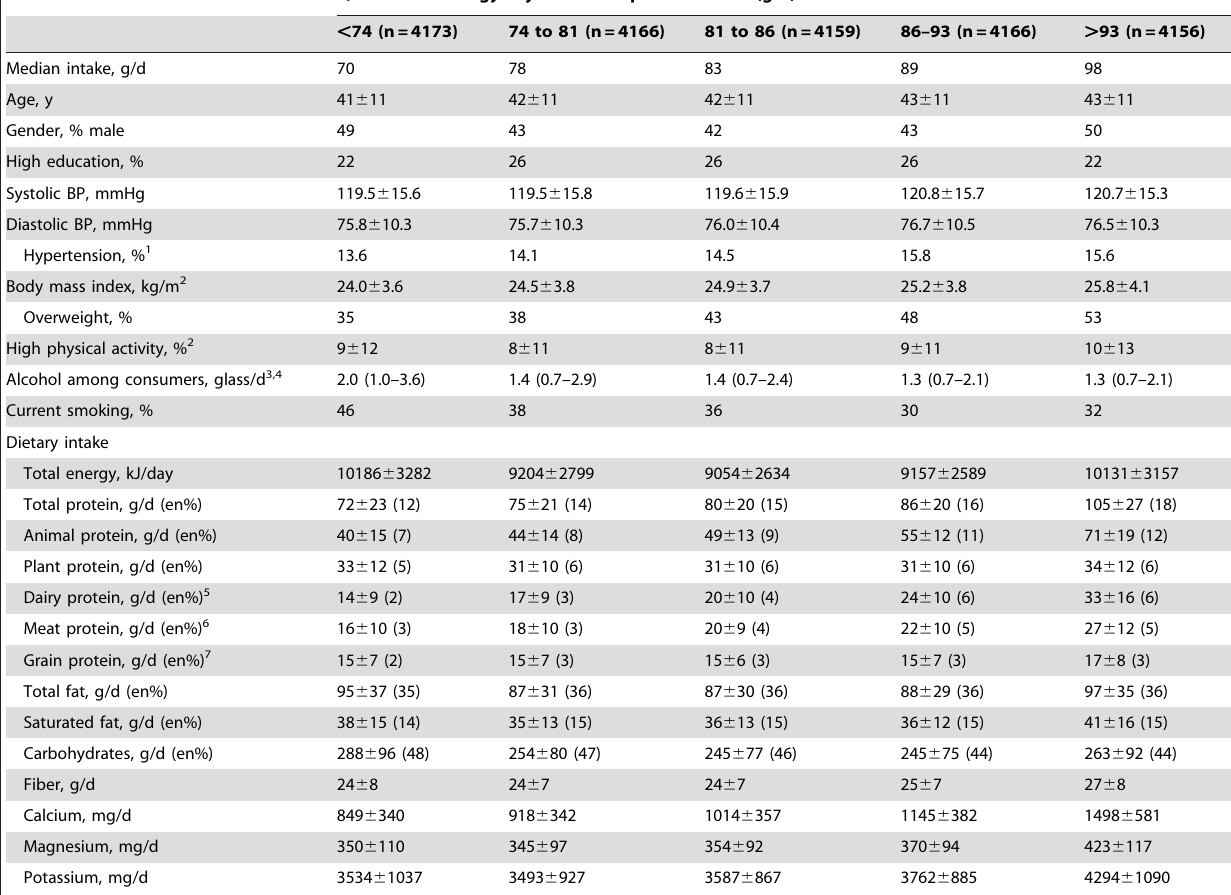
Quintiles of energy adjusted total protein intake